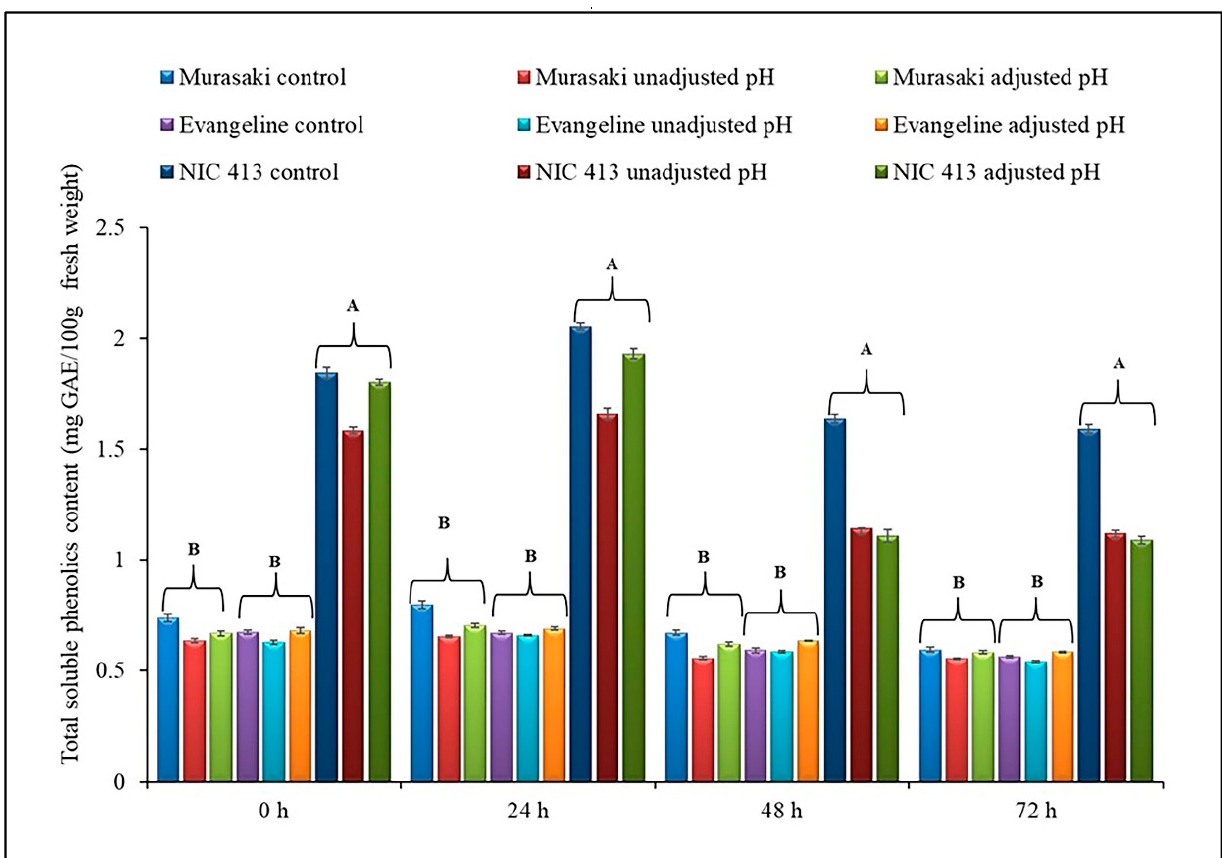
Figure 1. Total soluble phenolic content (mg GAE/100 g fresh weight) of unfermented (control) and fermented (pH unadjusted and adjusted) sample of three sweet potato cultivars at 0, 24, 48, and 72 h fermentation time points. Different uppercase letters (A, B) indicate statistically significant ( p < 0.05) differences between sweet potato cultivars at each fermentation time point.